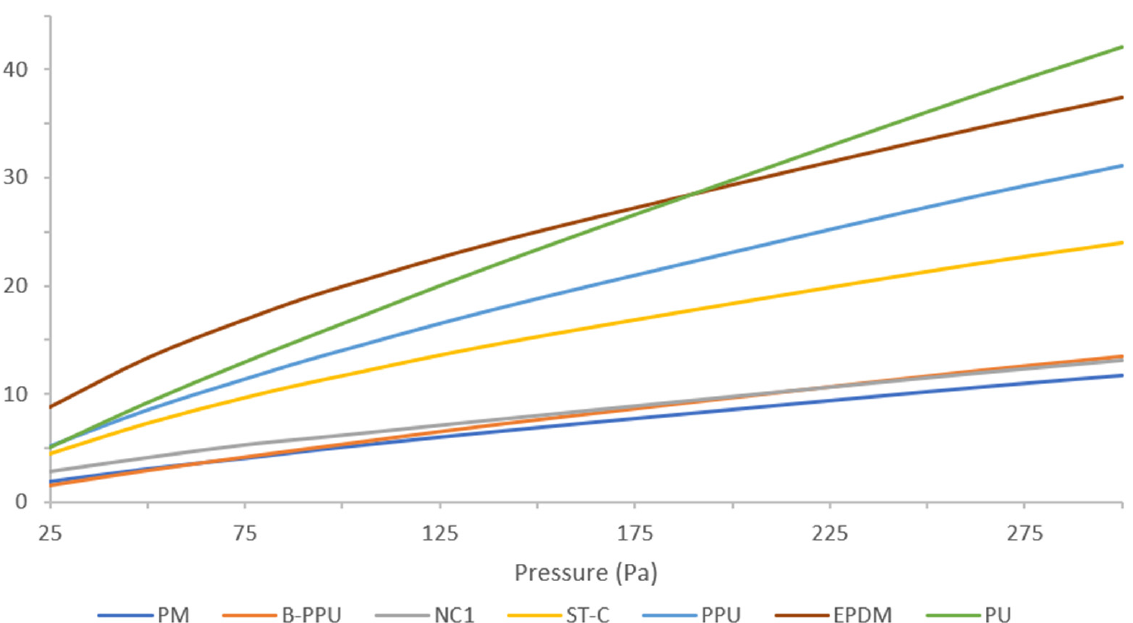
( b ) Figure 8. Thermographic analysis of the new concept 1 system at 0 Pa ( a ) and 50 Pa ( b ).